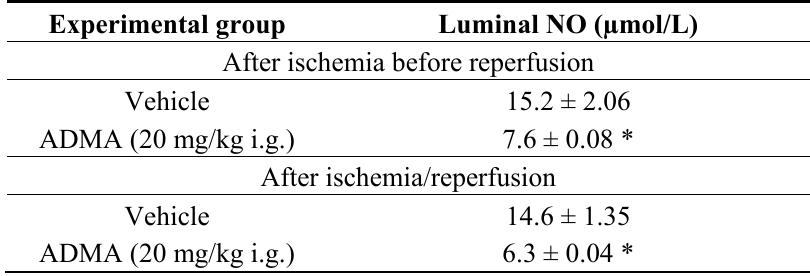
Table 2. Effect of pretreatment with vehicle (saline) or ADMA (20 mg/kg i.g.) on the luminal NO concentration measured in rats after ischemia alone (30 min), and in those with ischemia (30 min) followed by reperfusion (3 h). Mean ± S.E.M of 6 rats per each group. An asterisk indicates a significant decrease ( p < 0.05) as compared to the values obtained in vehicle-control rats after ischemia alone, or after